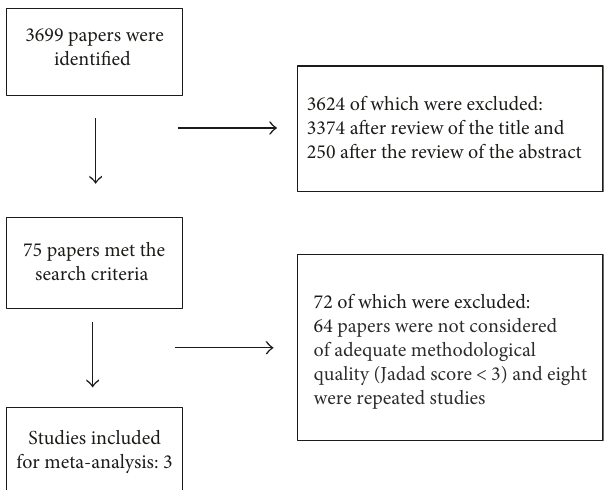
Figure 1: Flow diagram of the selection process of